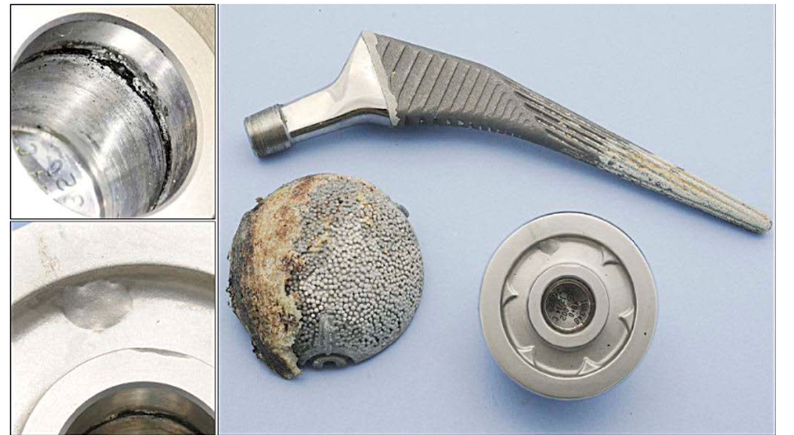
Figure 1. Cobalt and Chromium Ion Levels.